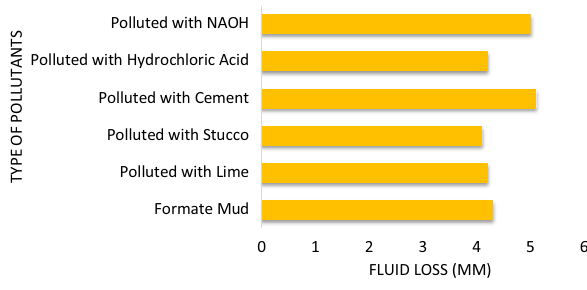
Fig. 5 pH changes in the pres- ence of several